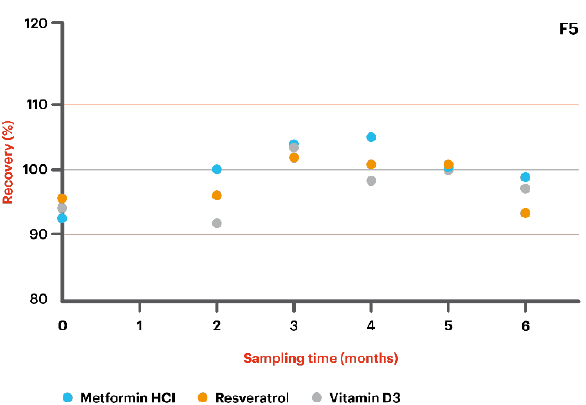
Figure 1. Stability of the selected APIs in Pentravan ® or Pentravan ® Plus. Red lines represent the lower and upper limits, corresponding to 90% and 110% of the labeled concentrations.